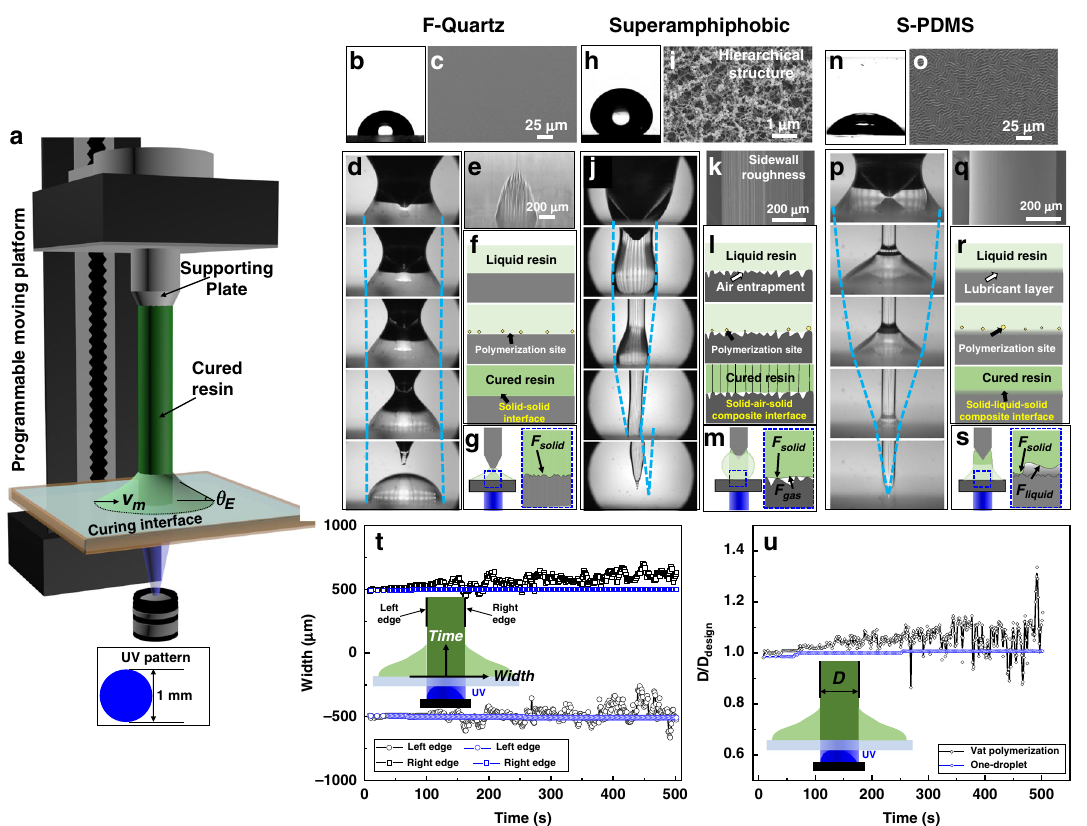
Fig. 2 The in fl uence of interfacial adhesion properties on the one-droplet 3D printing process. a Scheme of the experimental setup for the one-droplet 3D printing process. Inset is the scheme of the UV pattern employed in Fig. 2. v m and θ E are the maximum velocity and the equal contact angle on the curing interface for smooth droplet retraction. b , c Wettability and SEM characterization of the fl uorinated quartz (F-quartz) surface, respectively. d Optical captures of the UV curing process on the F-quartz surface. e Optical image of the cured structure remaining on the F-quartz surface. f Scheme of the generation of the pure solid – solid interface on the F-quartz surface. g Scheme of the pure solid – solid adhesive force. h , i Wettability and SEM characterization of the superamphiphobic surface, respectively. j Optical captures of the UV curing process on the superamphiphobic surface. k SEM image of the sidewall of the cured structure on the superamphiphobic surface, which displays a striped pattern along the printing direction. l Scheme of the generation of a solid-air-solid composite interface on the superamphiphobic surface. m Scheme of the composite adhesive force comprises solid – solid and solid – gas adhesive force. n , o Wettability and SEM characterization of the S-PDMS surface, respectively. p Optical captures of the UV curing process on the S-PDMS surface to form a columnar structure. q SEM image of the smooth sidewall of the cured structure on the S-PDMS surface. r Scheme of the generation of a solid-liquid-solid composite interface on the S-PDMS surface. s Scheme of the composite adhesive force comprised from solid – solid and solid-lubricant adhesive force. t The time-variant width change of the left and right edges on the structure constructed from one-droplet, with vat polymerization process as control. Blue and black lines represent width change curves of the one-droplet and the vat polymerization process, respectively. Circles and squares represent the left and right edges of the printed structure, respectively. u The time-variant D / D design ratio of one-droplet printing, with the vat polymerization process as control. Blue and black lines represent D / D design ratio change curves of the one-droplet and the vat polymerization process,